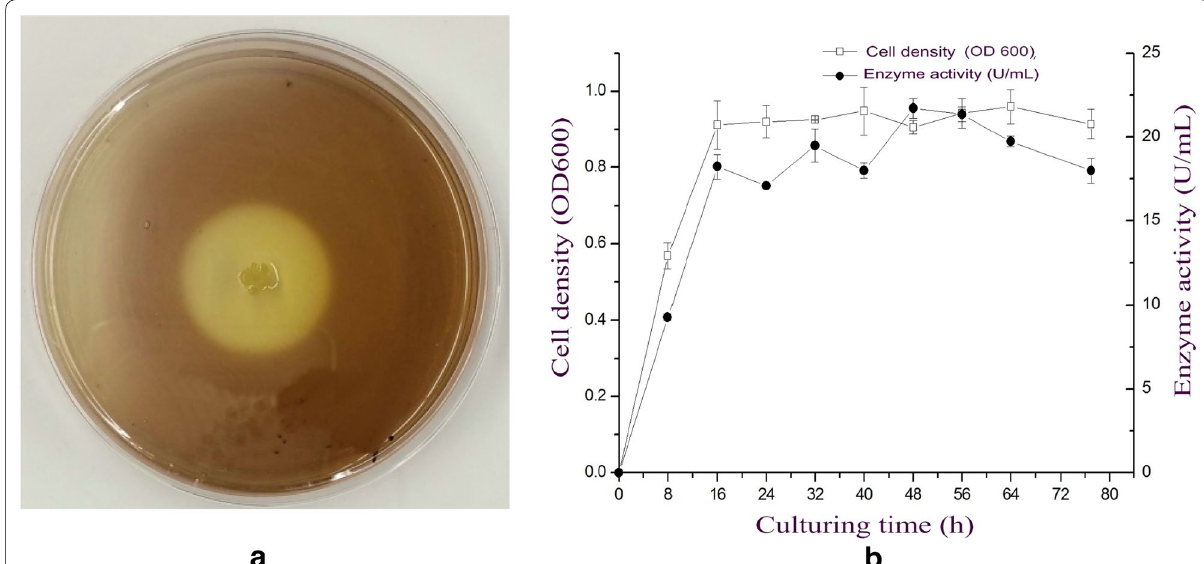
Fig. 1 a The halo of the strain B. velezensis A4 on CMC plate. The strain was grew on MSM with 1% (w/v) iodine solution; b the growth curve of B. velezensis A4. The strain was inoculated in 50 ml MSM liquid medium in a 250-ml Erlenmeyer flask and cultured at 37 °C for 80 h in a shaker at 200